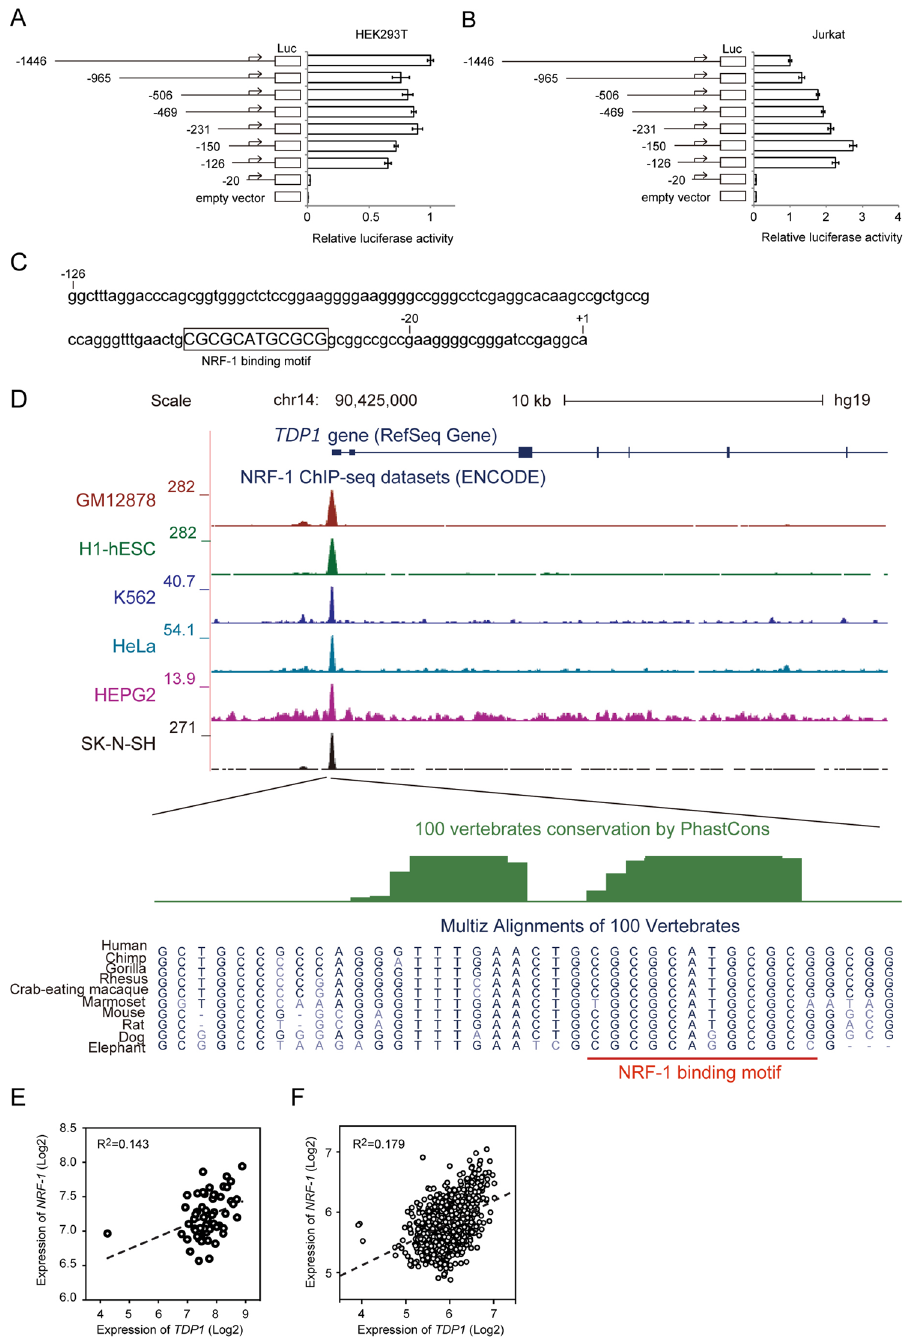
Figure 1. Identification of the core promoter of TDP1 . ( A ) HEK293T cells and ( B ) Jurkat T cells were transfected with a luciferase-reporter vector driven by truncated TDP1 promoter. Relative luciferase activity was calculated by comparison with the luciferase activity of the largest construct of TDP1-Luc ( − 1446/ + 193). Data shown are the mean ± SD ( n = 3). ( C ) NRF-1-binding motif in the region between − 126 and − 20 of the TDP1 promoter identified by a JASPAR database search (http://jaspar.genereg.net). The “CGCGCATGCGCG” in the square is an NRF-1-binding motif. ( D ) Illustration of the NRF1-binding site in the TDP1 promoter. ENCODE ChIP-seq data for NRF-1 is shown on UCSC genome browser view (Kent et al . Genome Res. 2002 Jun;12(6):996-1006). Sequences surrounding the NRF-1 binding motif are zoomed in below. Phastcon vertebrate conservation (Siepel et al . Genome Res. 15, 1034–1050 (2005)) is shown in green, and NRF-1 binding motif is highlighted in red. ( E ) Correlation between the expression levels of TDP1 and NRF-1 was analyzed in the NCI-60 human-tumor cell-line panel. The broken line represents the regression curve (Y = 0.17X + 5.85). R 2 = 0.143, P = 0.003, n = 59. ( F ) Correlation between the expression levels of TDP1 and NRF-1 was analyzed in the Cancer Cell Line Encyclopedia. The broken line represents the regression curve (Y = 0.37X + 3.60). R 2 = 0.179, P < 0.0001, n =